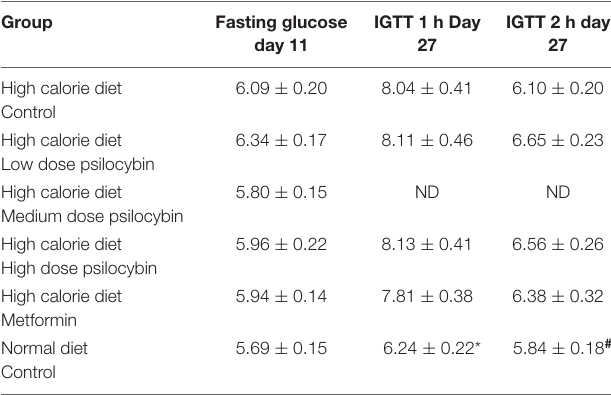
TABLE 1 | Fasting glucose levels at treatment day 11 and during intraperitoneal glucose tolerance test (IGTT) at treatment day